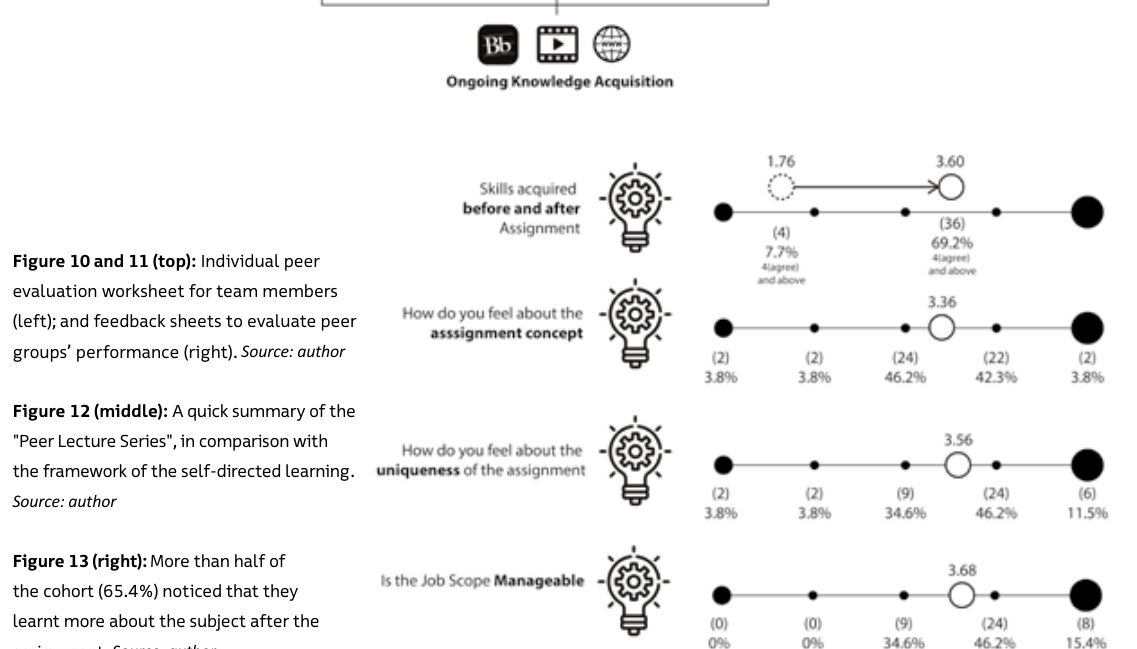
Figure 10 and 11 (top): Individual peer evaluation worksheet for team members (left); and feedback sheets to evaluate peer groups’ performance (right). Source: author Figure 12 (middle): A quick summary of the "Peer Lecture Series", in comparison with the framework of the self-directed learning.